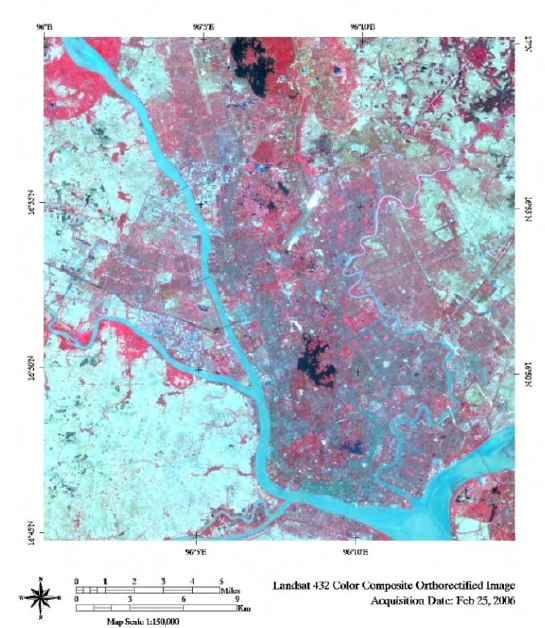
Figure 5. Landsat 432 Color Composite Ortho-rectified Image acquisition at Feb 25,2006